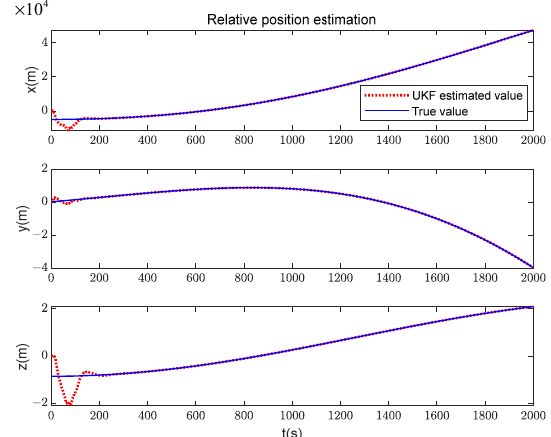
Figure 10. Comparison of relative position parameters. Relative velocity estimation